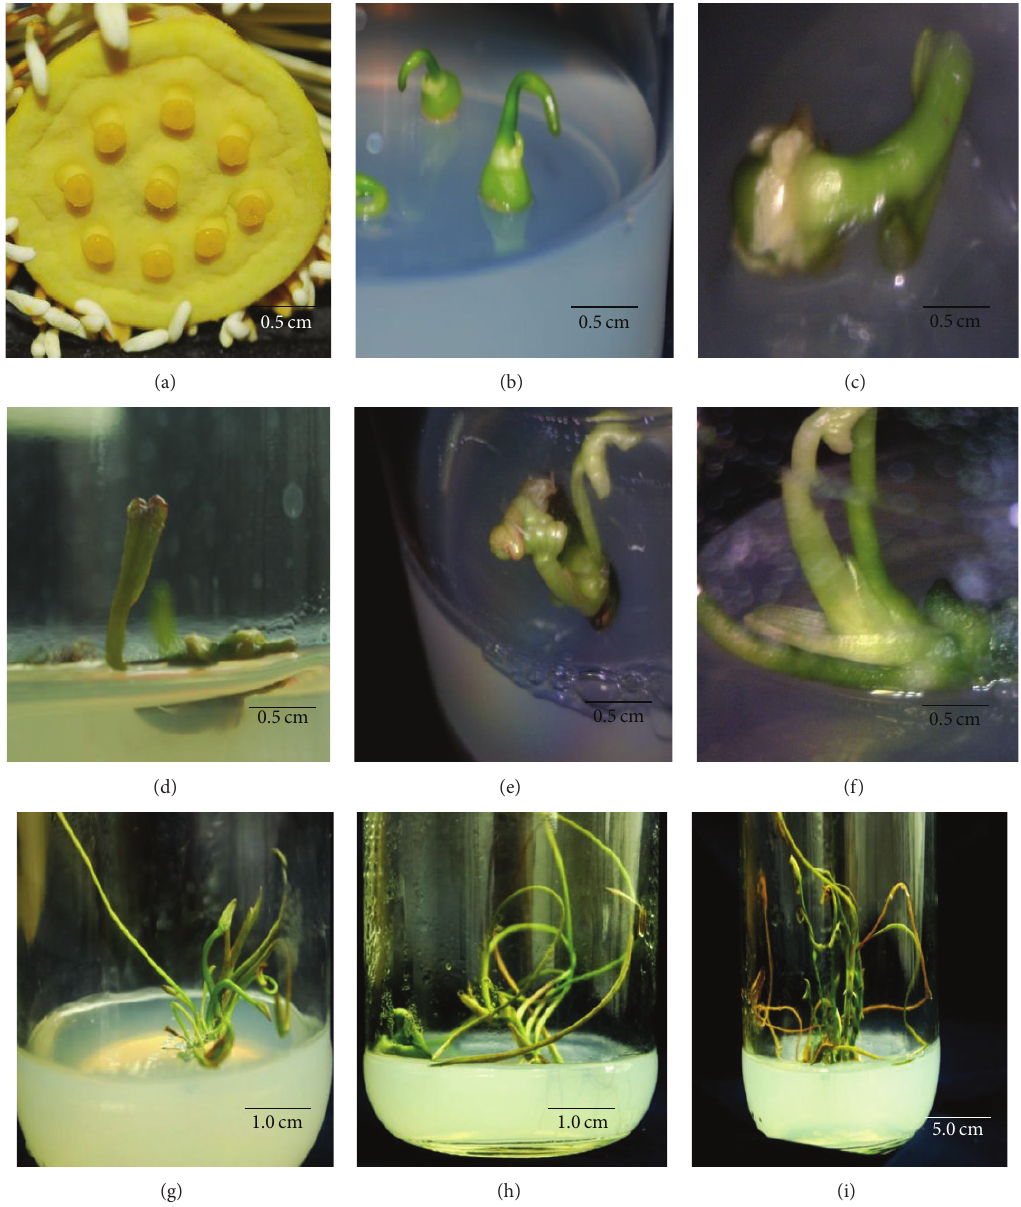
Figure2:EffectsofBAPandNAAonshootformationfromtheimmatureexplants(yellowplumule)of N. nucifera